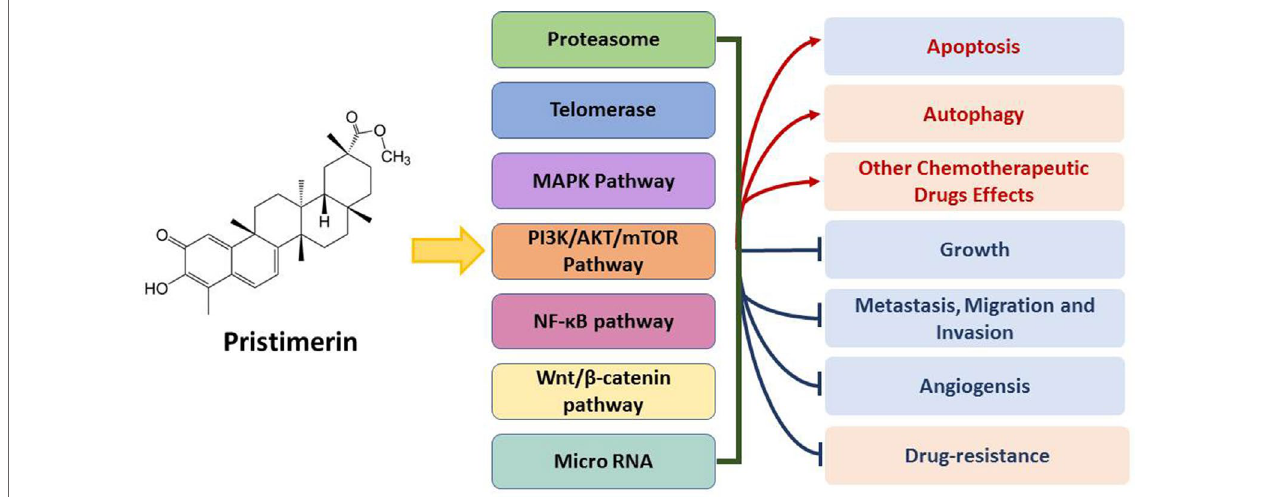
FIGURE 2 | Brief summary of anti-cancer mechanisms and activities of